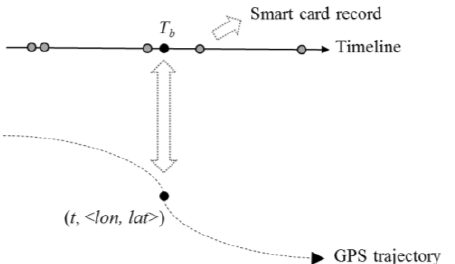
Figure 3. Illustration of the process of matching smart card data and bus GPS